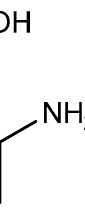
Figure 5. Illustrated structure of mandelic acid .